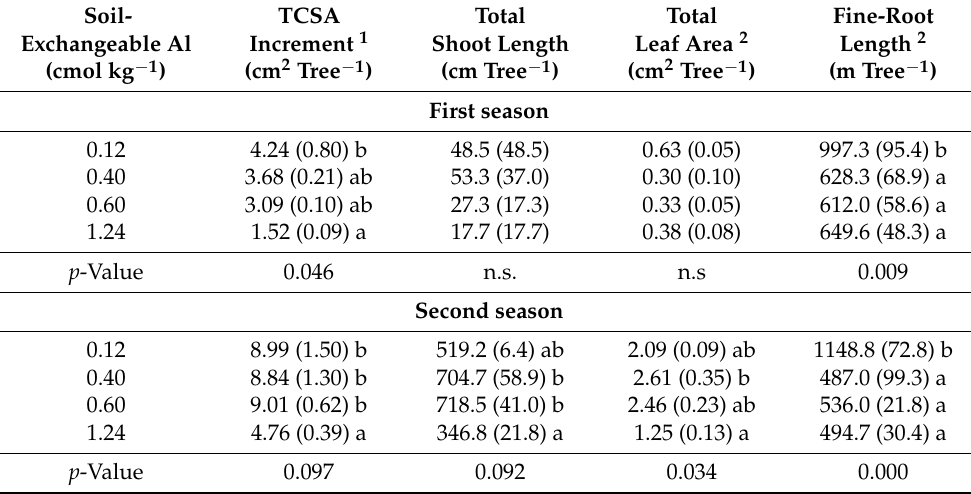
Table 2. Vegetative growth variables and fine-root length in sweet cherry trees growing in a volcanic soil with increasing concentrations of exchangeable Al. Values are the means, with standard errors in parentheses ( n =